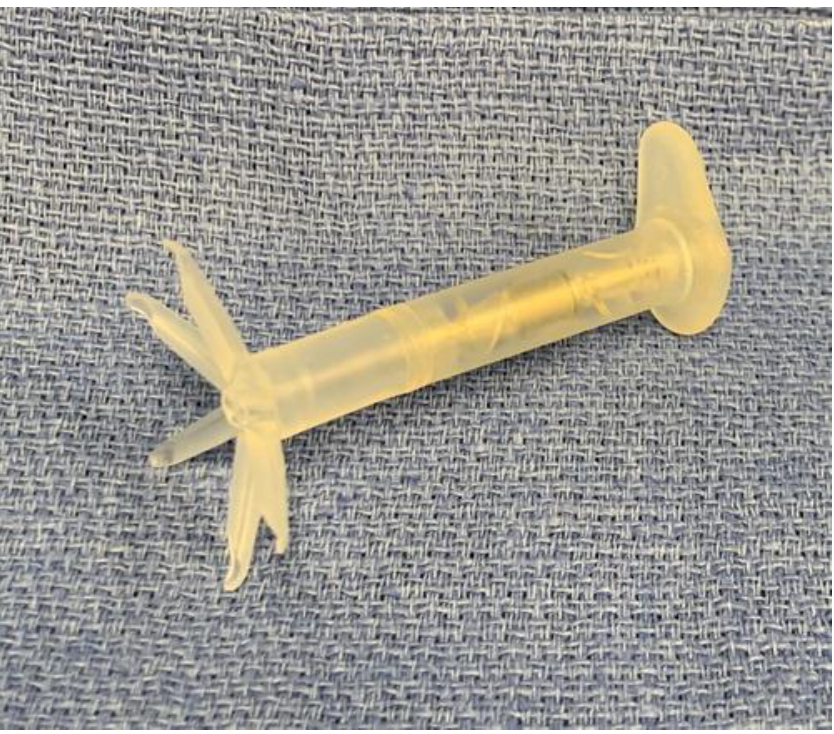
Figure 10. The inFlow ™ intraurethral valve pump for women [39]. Copyright 2020, Taylor and Francis.